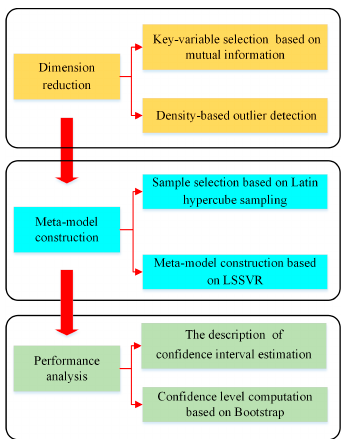
Figure 3. The overview of the robust performance analysis in product development.